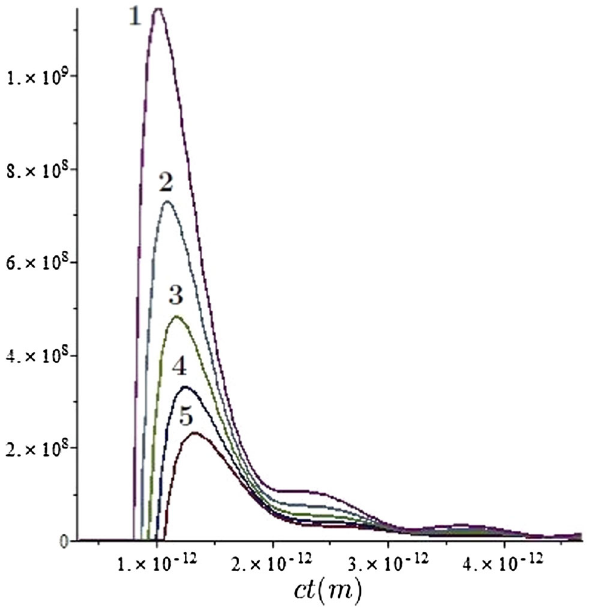
Fig. 3 The function R ( t 0 , t ) versus ct in the domain t m < t < 14 t m for m = m e and: t 0 = 2 . 4 t m (1), t 0 = 2 . 6 t m (2), t 0 = 2 . 8 t m (3), t 0 = 3 t m (4), t 0 = 3 . 2 t m